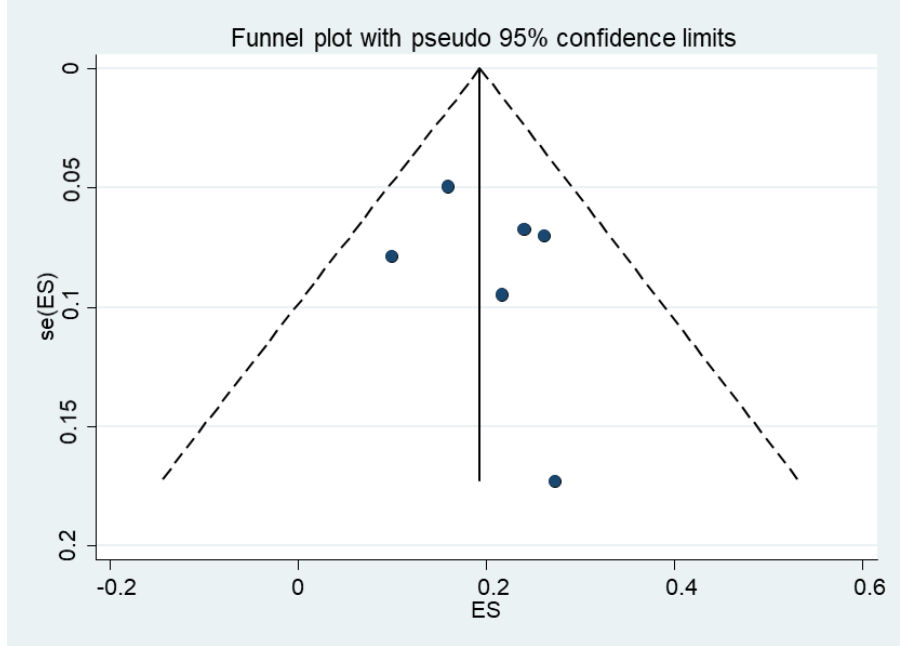
Figure A2. Funnel plot from the meta-analysis of dropout rates.